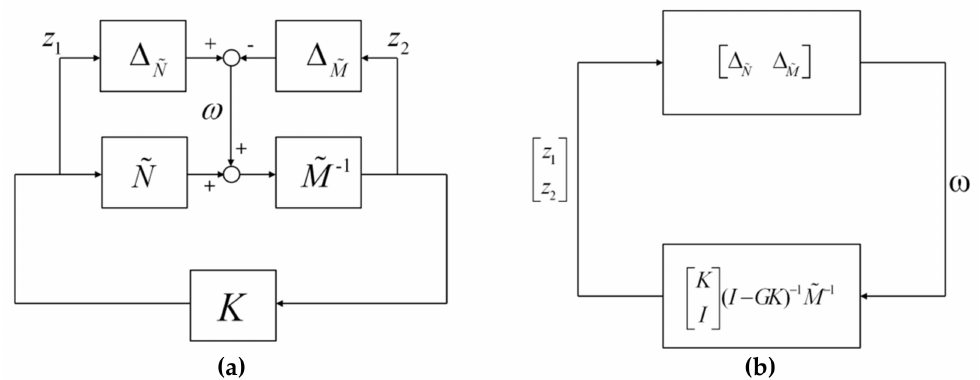
Figure A2. Robust stability analysis. ( a ) closed-loop system with the perturbed plant; ( b ) rearrangement for the Small-Gain theorem.